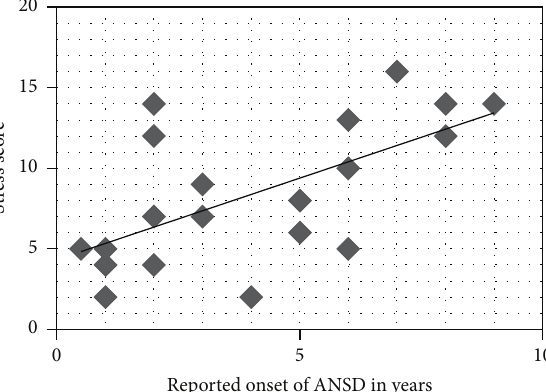
Figure 3: Scatter plots of correlation between the reported onset of ANSD in years and the different scales of DASS.